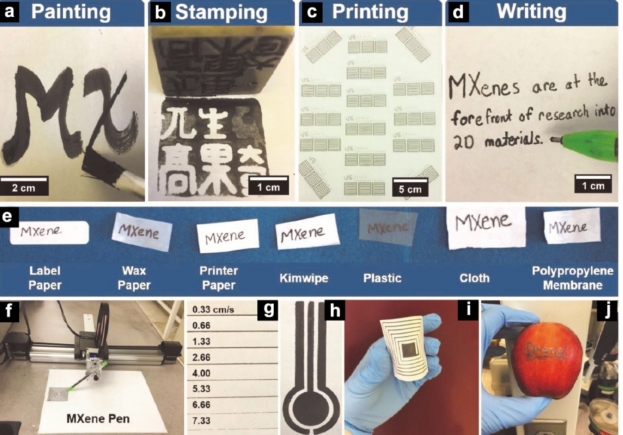
Figure 8. ( a – e ) Written MXene on various substrates via various ways, ( f , g ) using the automatic drawing tool of AxiDraw for patterning by using the Ti 3 C 2 inks, ( h , i ) versatile patterning using AxiDraw, and ( j ) a demonstration of MXene inks drawn on an apple